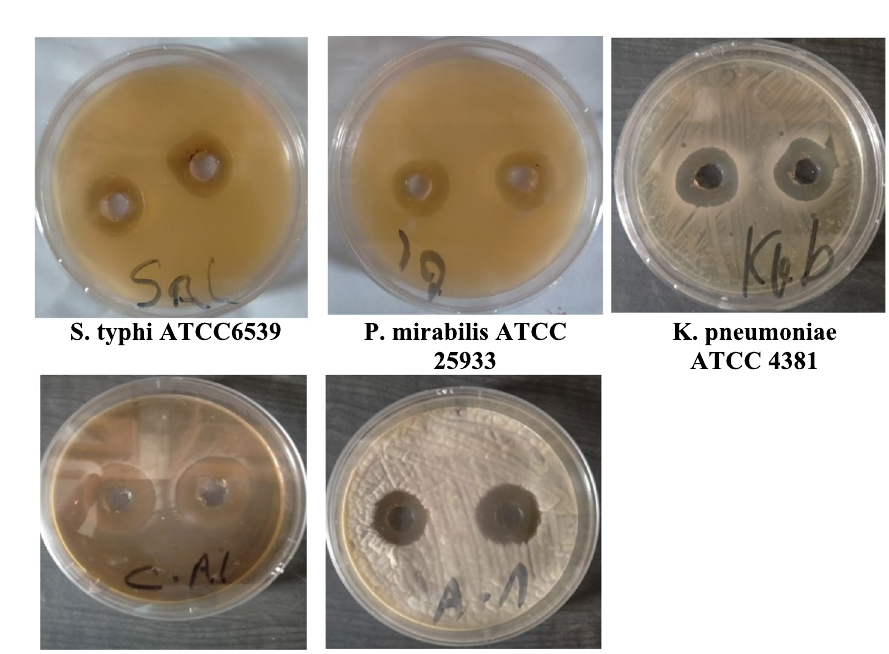
Fig. 5 Antimicrobial activity of purified